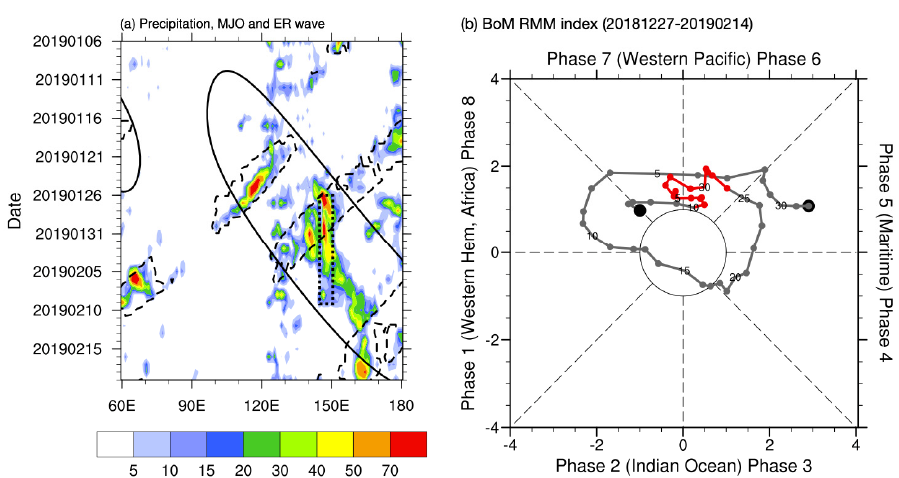
Figure 3. The pentad-mean CMORPH precipitation map (shading, unit: mm day − 1 ), 850-hPa wind field (vectors, unit: m s − 1 ), ( a – f ) for the pentads from 16-20 January (Pentad 4) to 10–14 February (Pentad 9) in 2019, which covers the period of 2018/19 SPRE over northeastern Queensland.